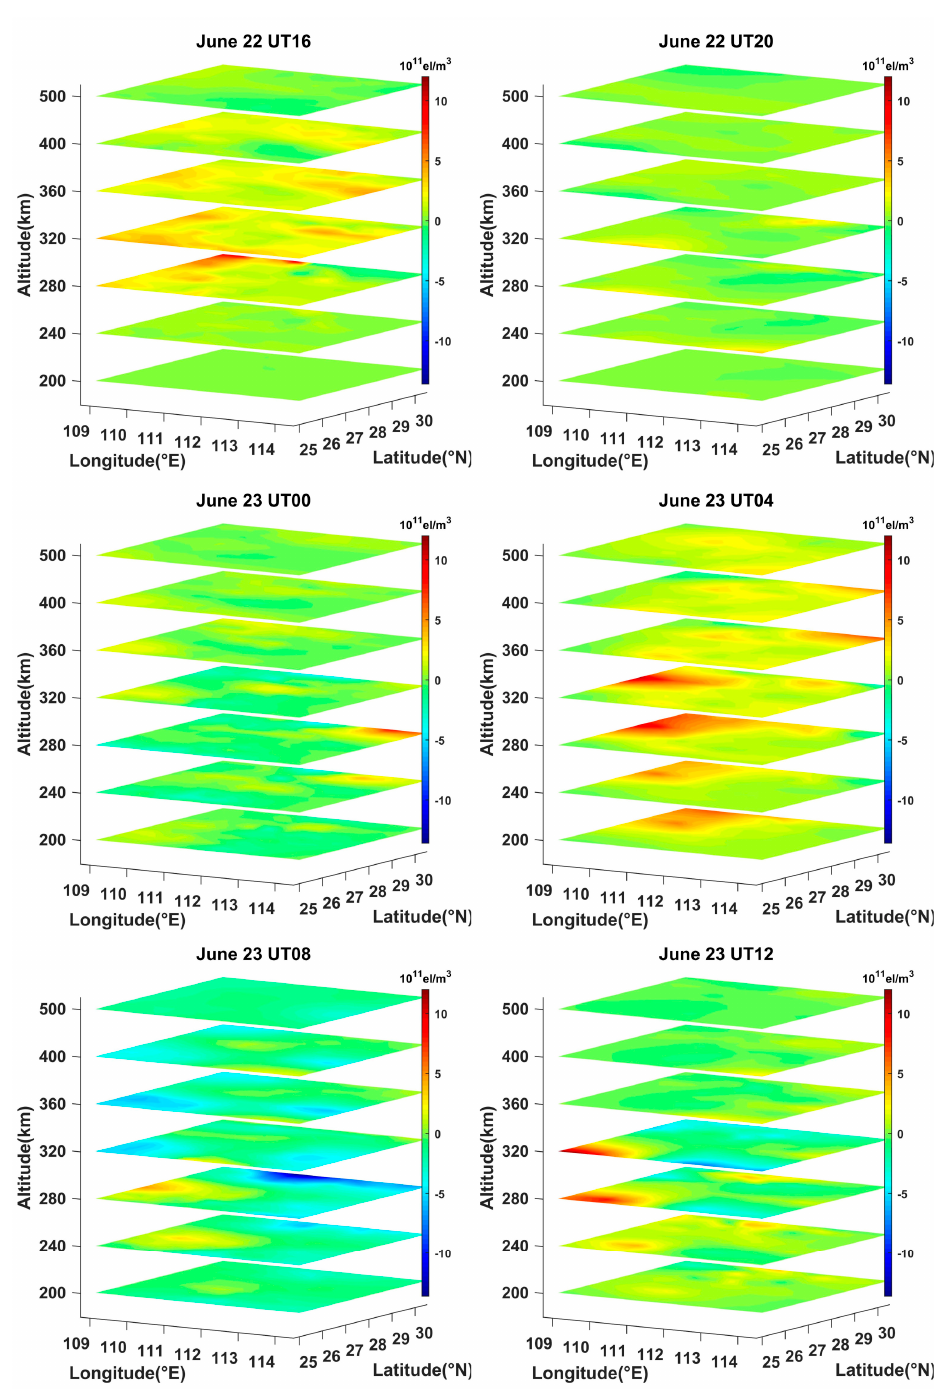
Figure 10. Time-series variation of three-dimensional di ff erential IED in the reconstructed region on 22 and 23 June